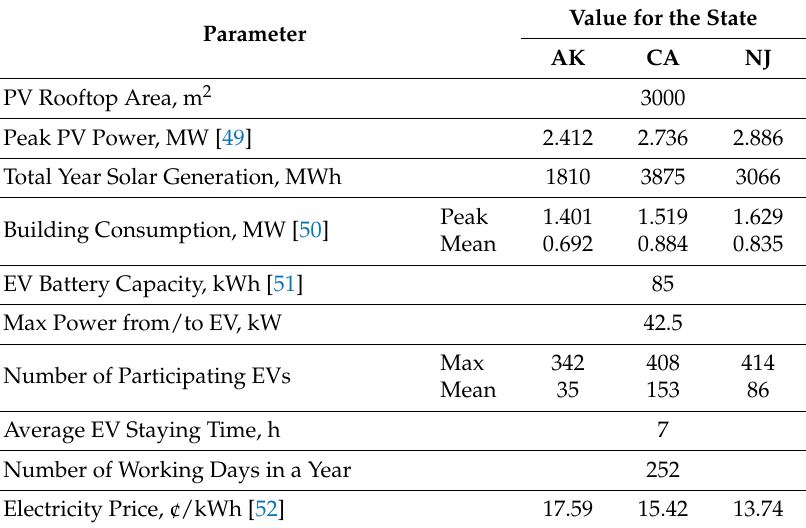
Table 1. The parameters